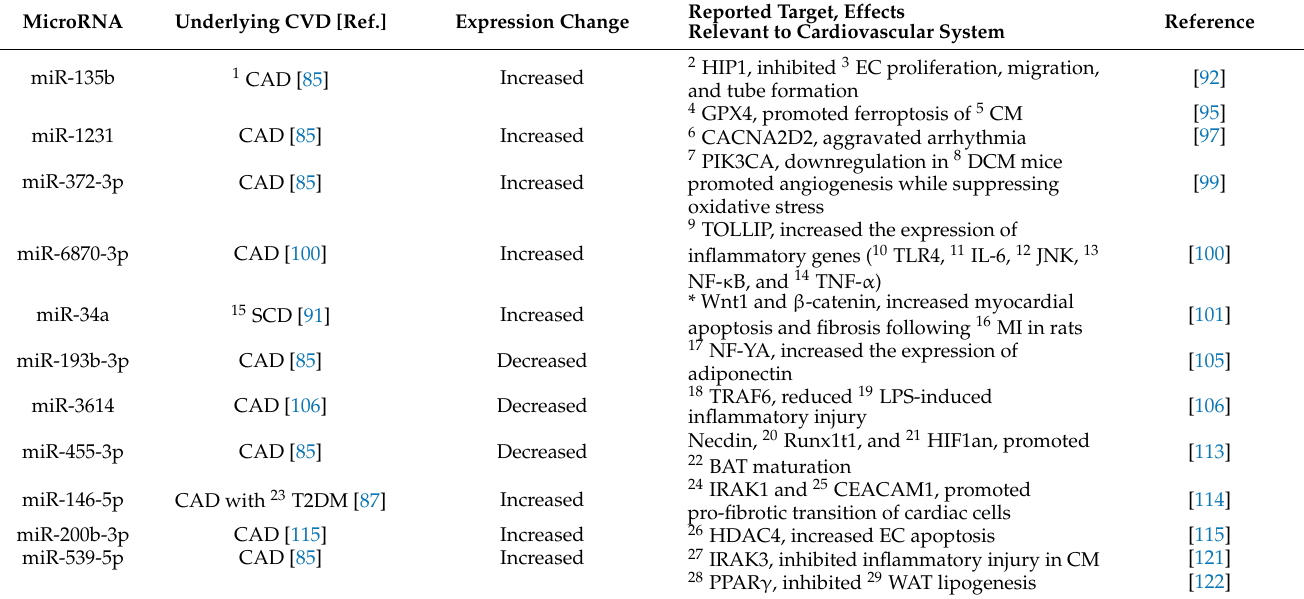
Table 2. MicroRNAs reported to be differentially expressed in EAT of CVD